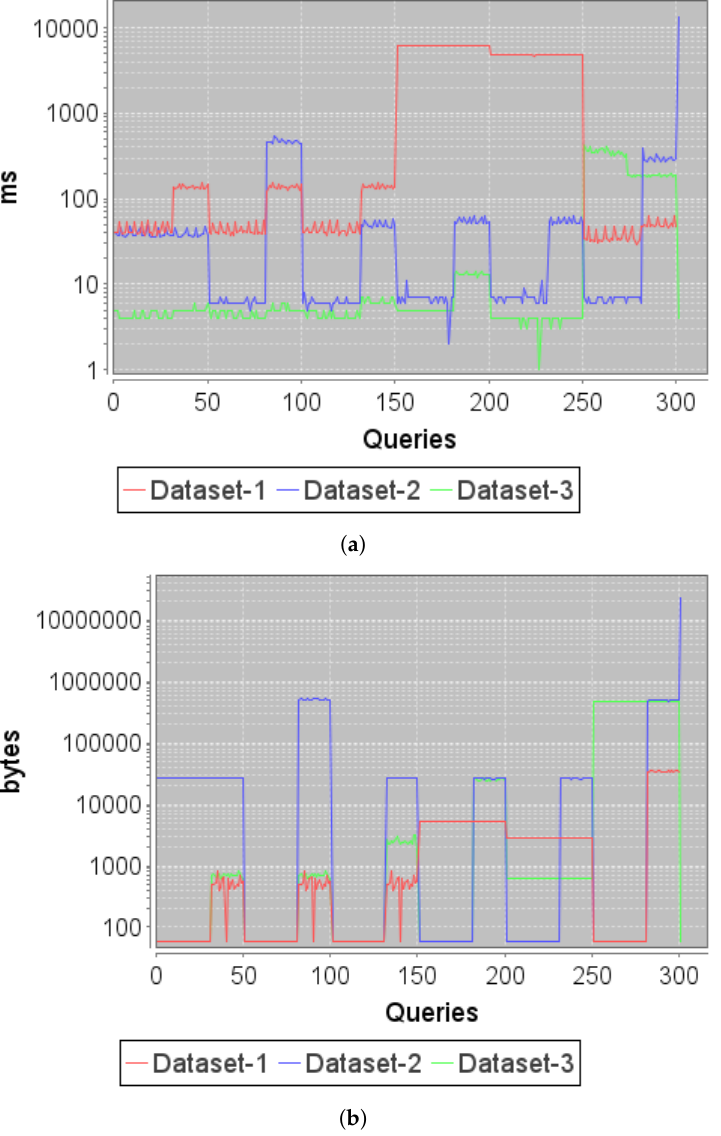
Figure 7. Sequential query sets. ( a ) Sequential query sets. Response time in ms (milliseconds). ( b ) Sequential query sets. Response volume in